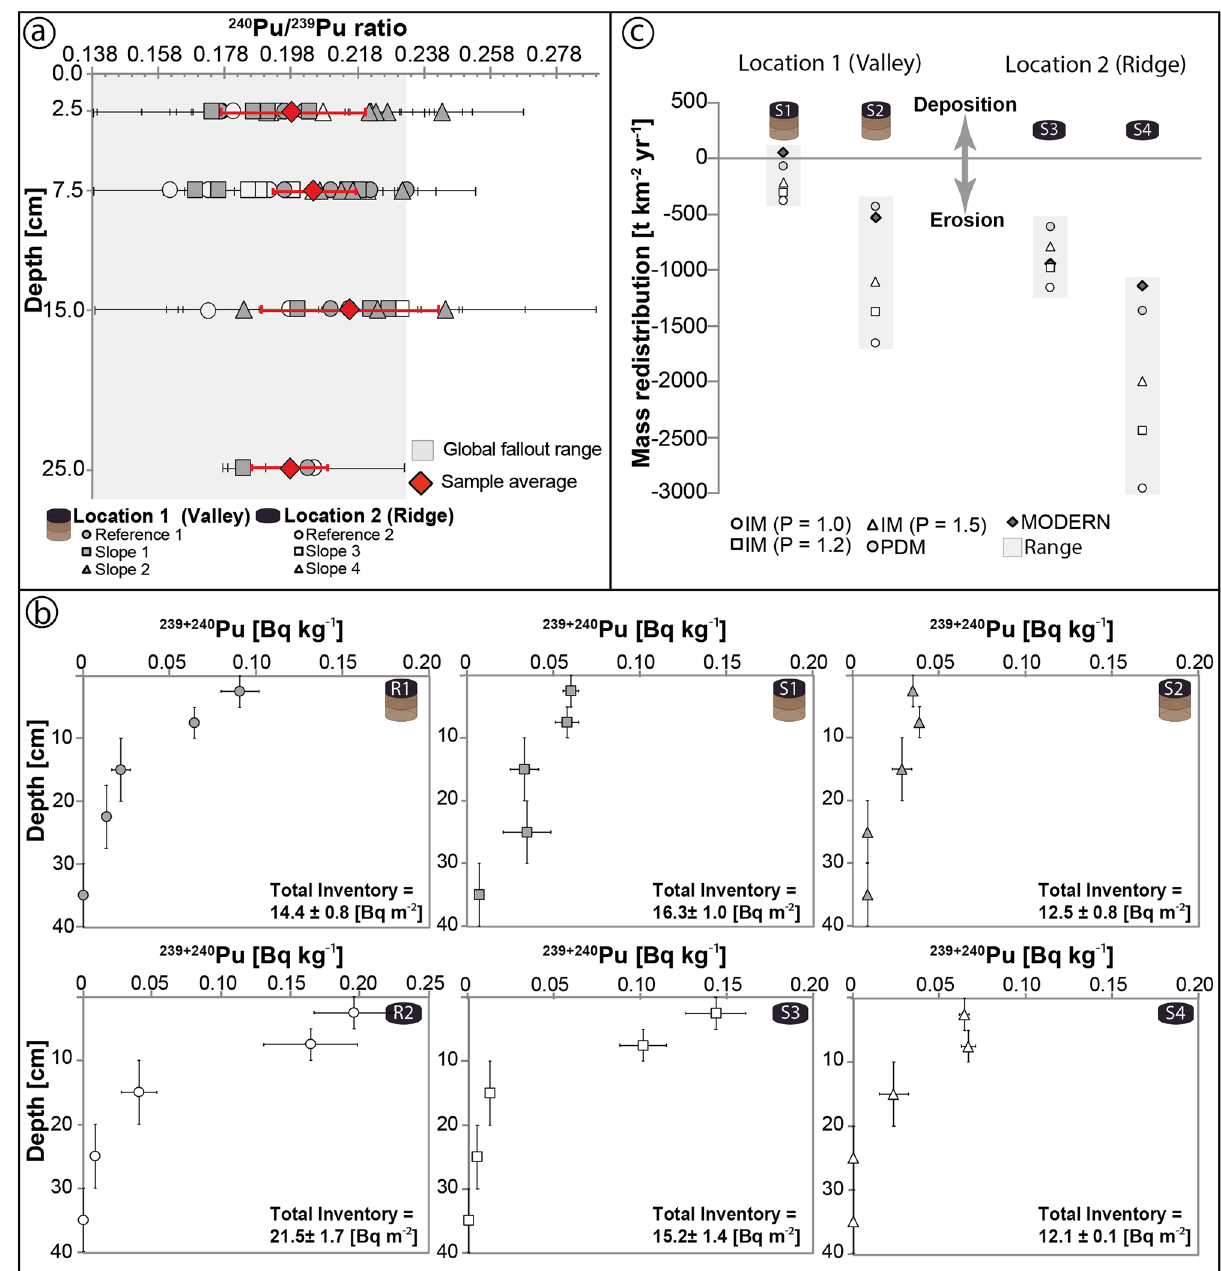
Figure 3. ( a ) The 240 Pu/ 239 Pu ratios and standard error of the soil samples as a function of soil depth. The average for each depth increment is given in red. The grey area indicates the global fallout range (0.185 ± 0.047) of the southern hemisphere 21 . ( b ) Depth-activity profiles (± standard error) of the investigated sites. ( c ) Calculated annual average soil redistribution for both reference sites using different particle size correction factors (P = 1.0, 1.2, 1.5) for the inventory method 22 , together with results of the profile distribution model 23,24 . Detailed values of the individual soil profiles of each pit are given in Supplementary Table